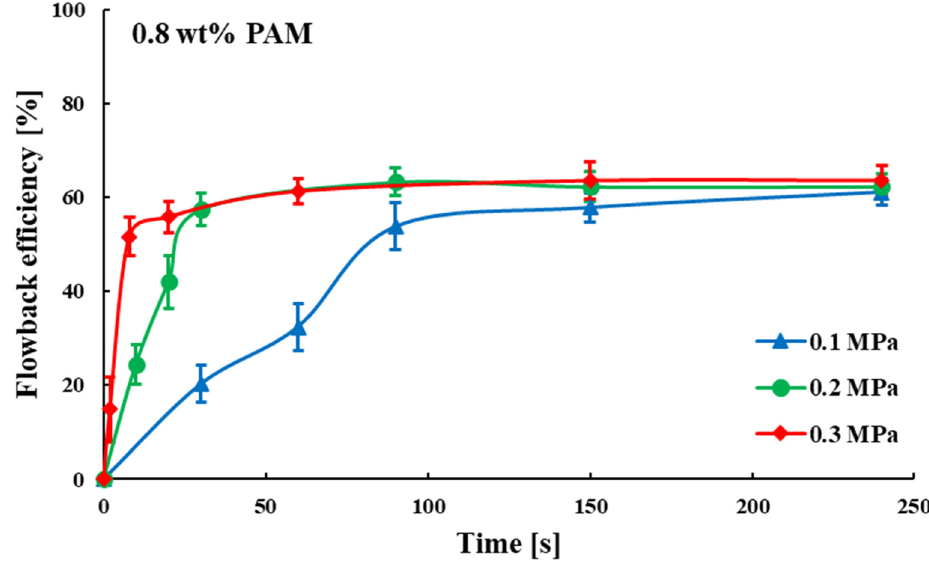
Figure 9. Relationship between time and fl owback e ffi ciency of fracturing fl uid (0.8 wt%).